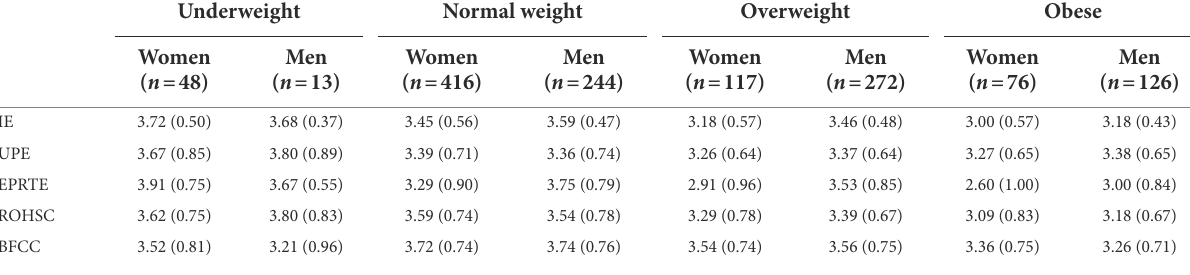
TABLE 3 Means and standard deviations for intuitive eating scores among BMI subgroups. Underweight Normal weight